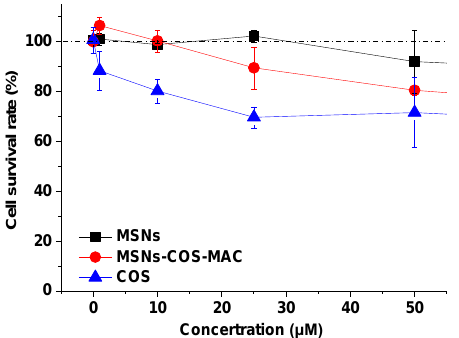
Figure 5. The cell survival rate of LX-2 cells at varying concentrations of pure COS, MSNs and MSNs-COS-MAC. Each data point represents the mean ± SD of three determinations.